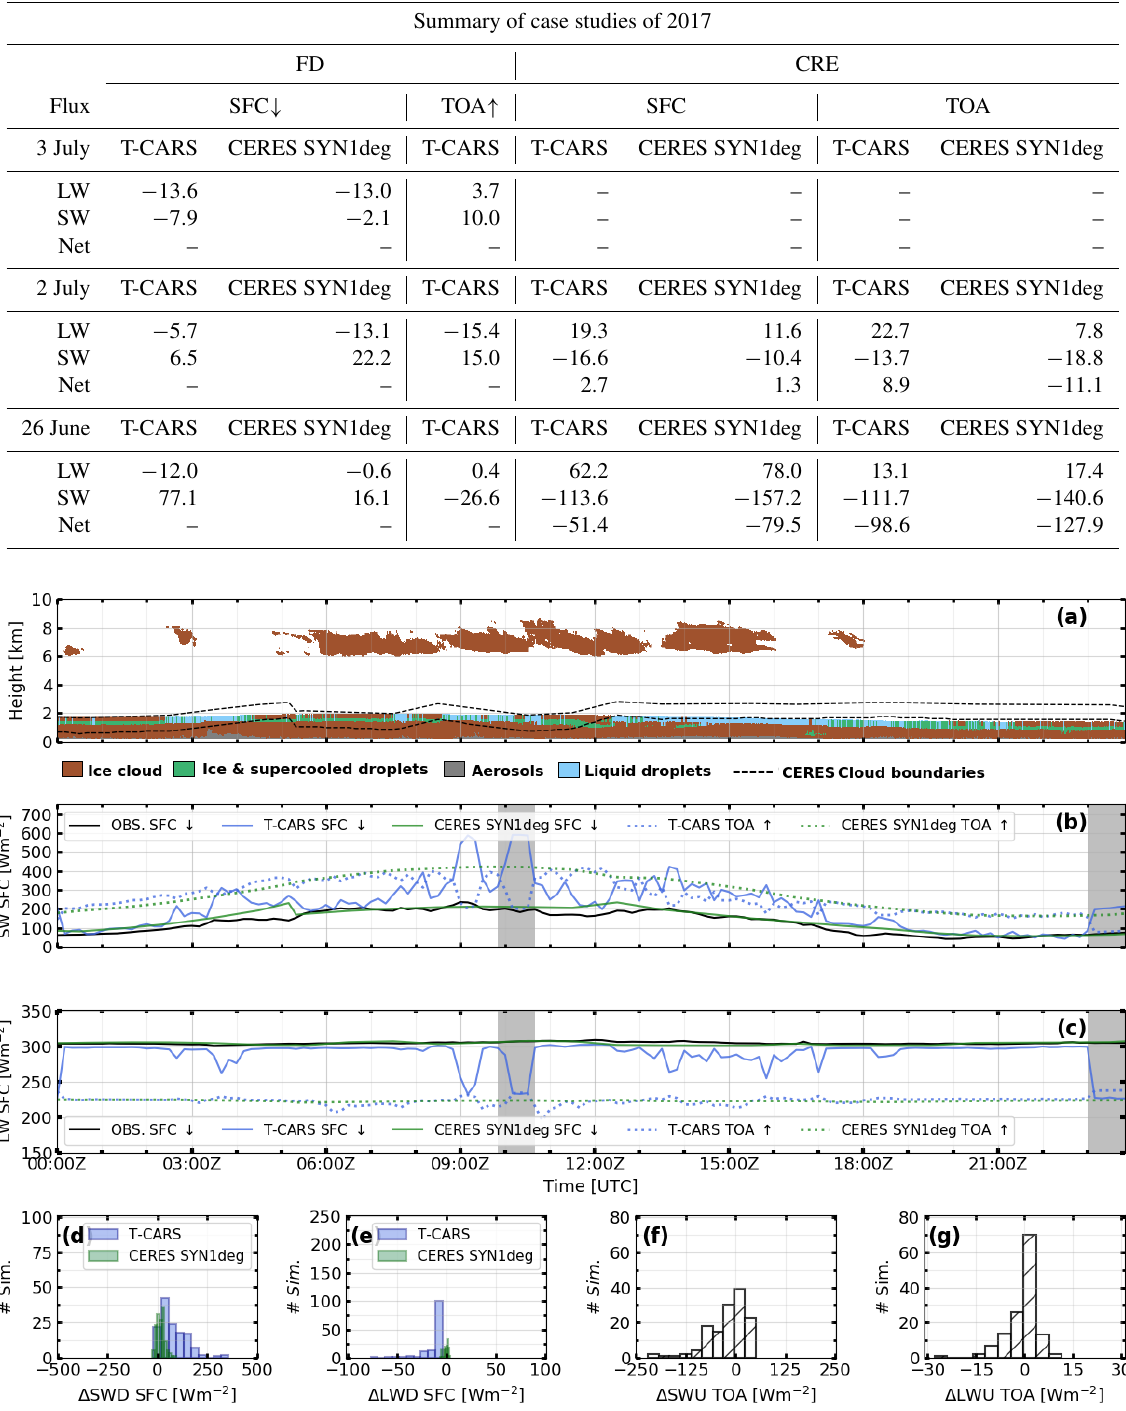
Figure 10. Same as Fig. 7, but for the 26 June 2017 case. The grey shading indicates periods with uncorrected attenuation by the Cloudnet